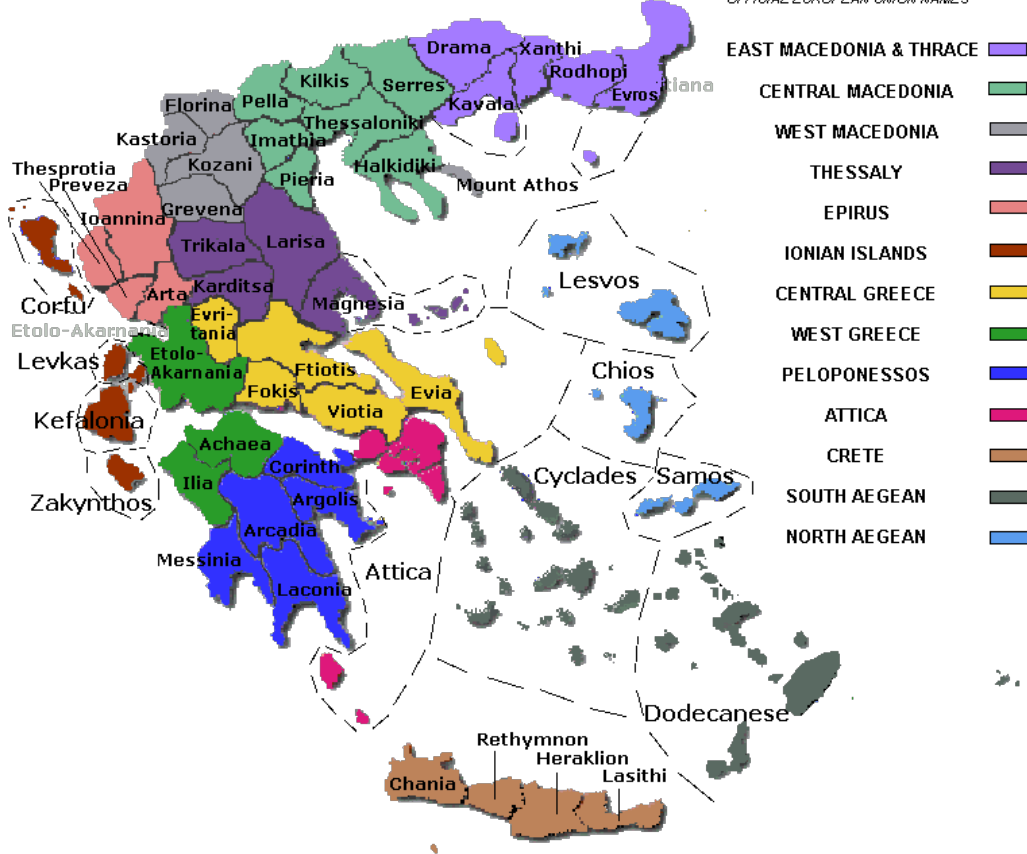
Figure 1. An administrative map illustrating regions and prefectures of Greece.